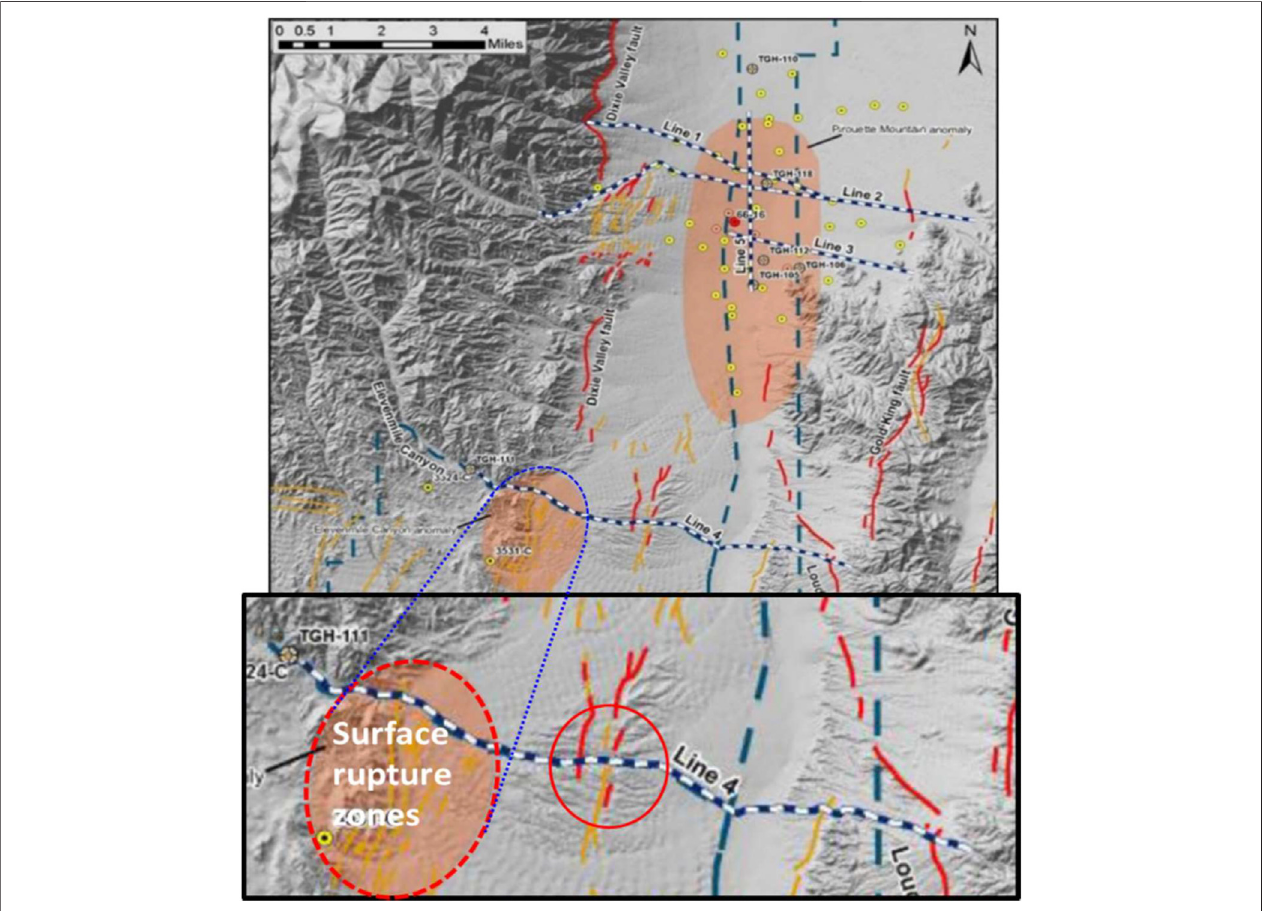
FIGURE 1 | Location map of the geothermal exploration areas at Pirouette Mountain and Eleven-Mile Canyon in southern Dixie Valley, Nevada, with fi ve lines of seismicsurveydepictedinrails.ThefaultsshownarefromtheU.S.GeologicalSurveyQuaternaryfaultandfolddatabase.Surfacerupturezonescorrespondtothe1954 earthquake sequence (Unruh et al., 2016). The northern shaded region is at Pirouette Mountain, and the southern shaded region is at Eleven-Mile Canyon.